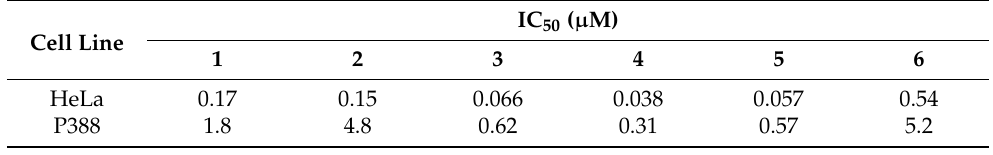
Table 3. Cytotoxicity against HeLa and P388 cells by compounds 1 − 6 .